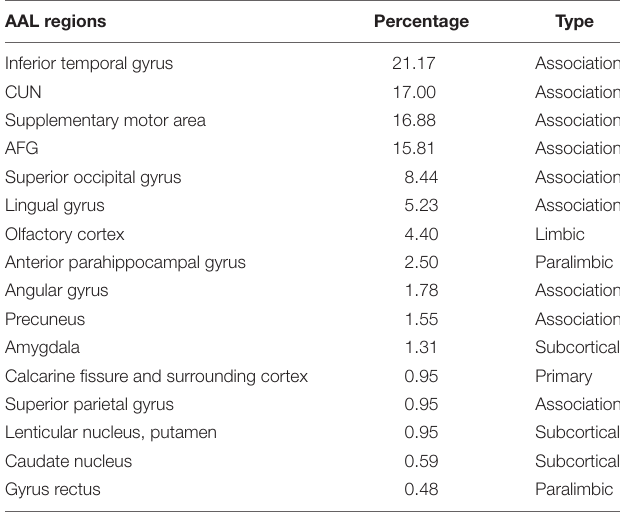
TABLE 2 | The percentage of voxels in AAL regions that exhibited a significant group difference in nodal efficiency asymmetry among three